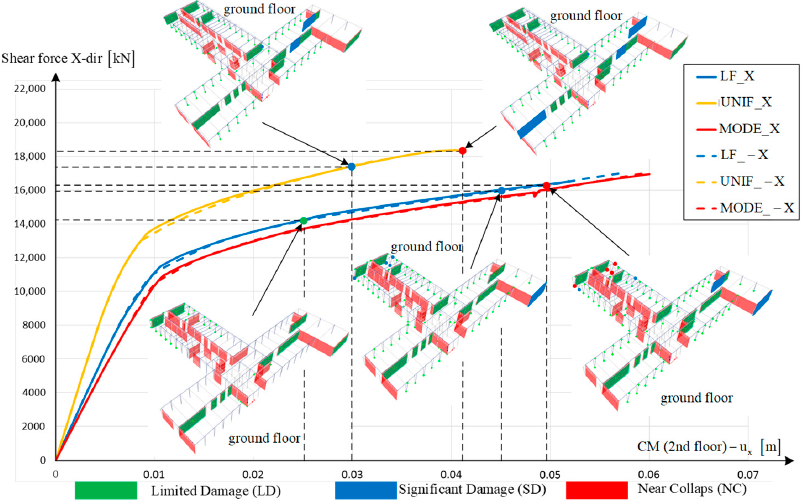
Figure 24. Pushover curves in X-dir for retrofitted structure.